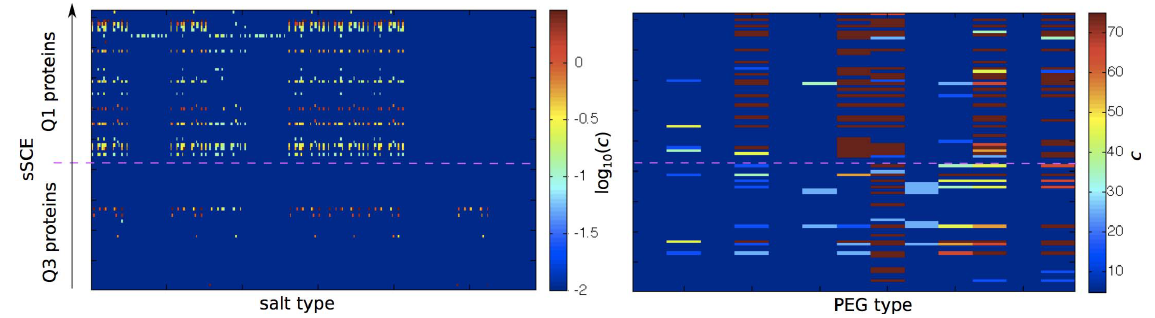
Figure 8. Optimal conditions for low crystallization propensity proteins in Q1 (upper side) and Q3 (lower side) for various salt types (molar concentration) and PEG types (% mass concentration). Proteins are ordered by sSCE; salt types are ordered by cation (ammonium, calcium, lithium, magnesium, manganese, potassium, rubidium, sodium, zinc, barium, cesium, cobalt, copper, iron, gadolinium, nickel, samarium, strontium, cadmium) and, within each cation, by anion (citrate, malonate, succinate, tartrate, acetate, bromide, cacodylate, carbonate, chloride, citrate tribasic, fluoride, formate, iodide, molybdate, nitrate, phosphate monobasic, phosphate dibasic, phosphate tribasic, pyrophosphate tetrabasic, sulfate, tetraborate, thiocyanate, thiosulfate, 4-aminosalicylate); and PEG types are ordered by molecular weight (200, 400, 550, 1000, 1500, 2000, 3350, 4000, 5000, 6000, 8000, 10000, 20000 g/mol).